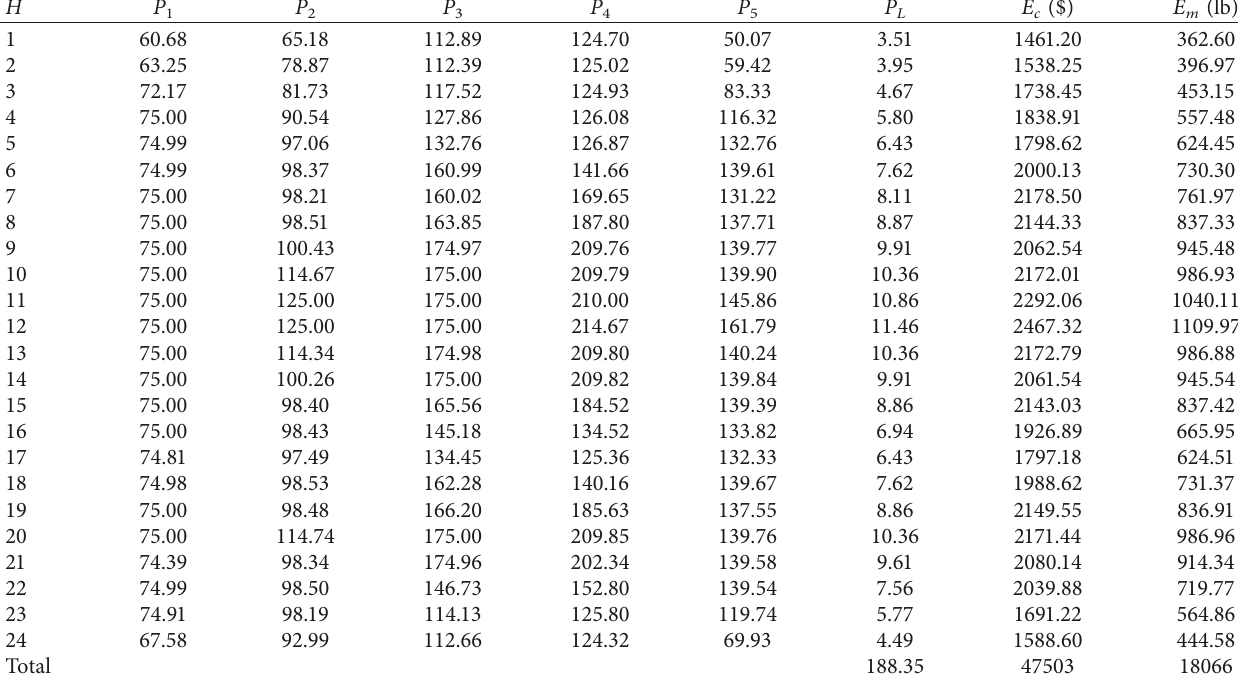
Table 4: Optimal compromise results for Case 1.